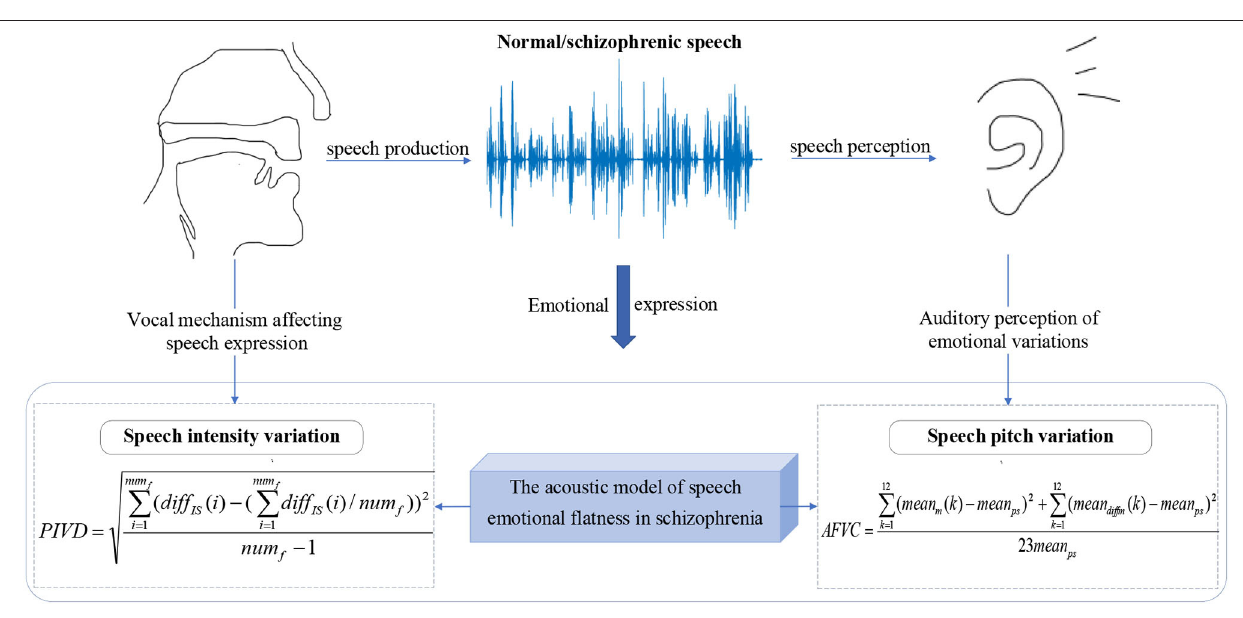
FIGURE 2 | The diagram of the acoustic model of speech emotional flatness in